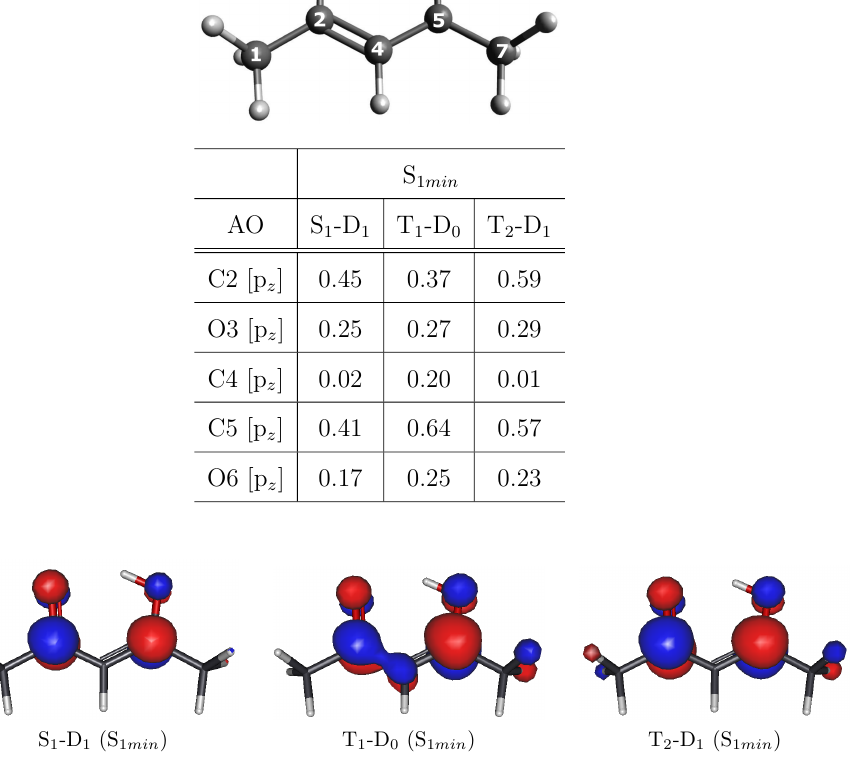
Figure 2. Selected coefficients of the Dyson orbitals expressed in the AO basis together with the Dyson orbital plots (CASSCF/cc-pVDZ) for the ionization from the excited states involved in the photody- namics process of